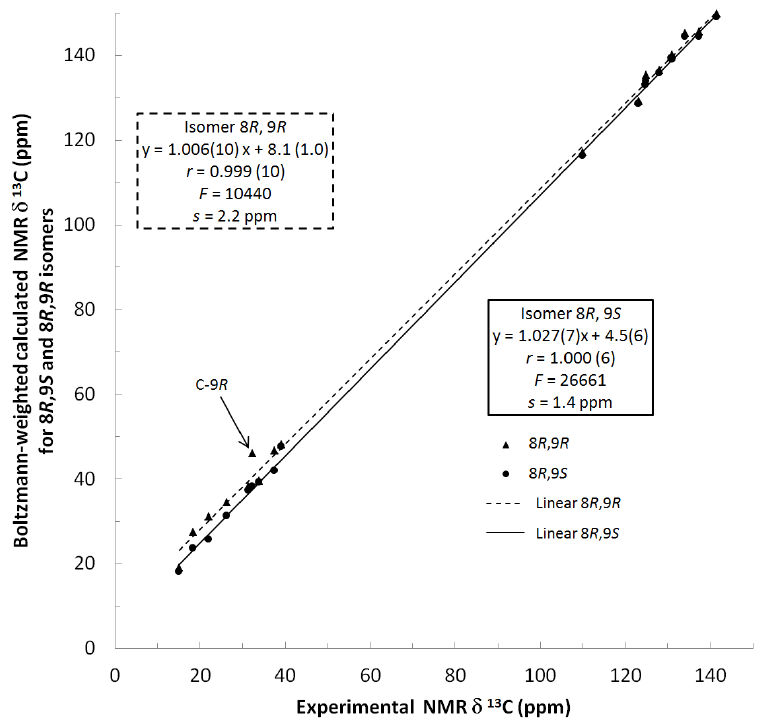
Figure 3. Plot of Boltzmann-weighted calculated NMR δ 13 C of 8 R , 9 S and 8 R , 9 R isomers versus experimental NMR δ 13 C of dodovisate C ( 1 ). Statistics for the regression of calculated versus experimental chemical shifts for both isomers. The slope, the intercept, the correlation coefficient (r) are followed by their standard error on the last digit(s) in brackets. F is the Fisher F-statistic and s the standard error of the fit.